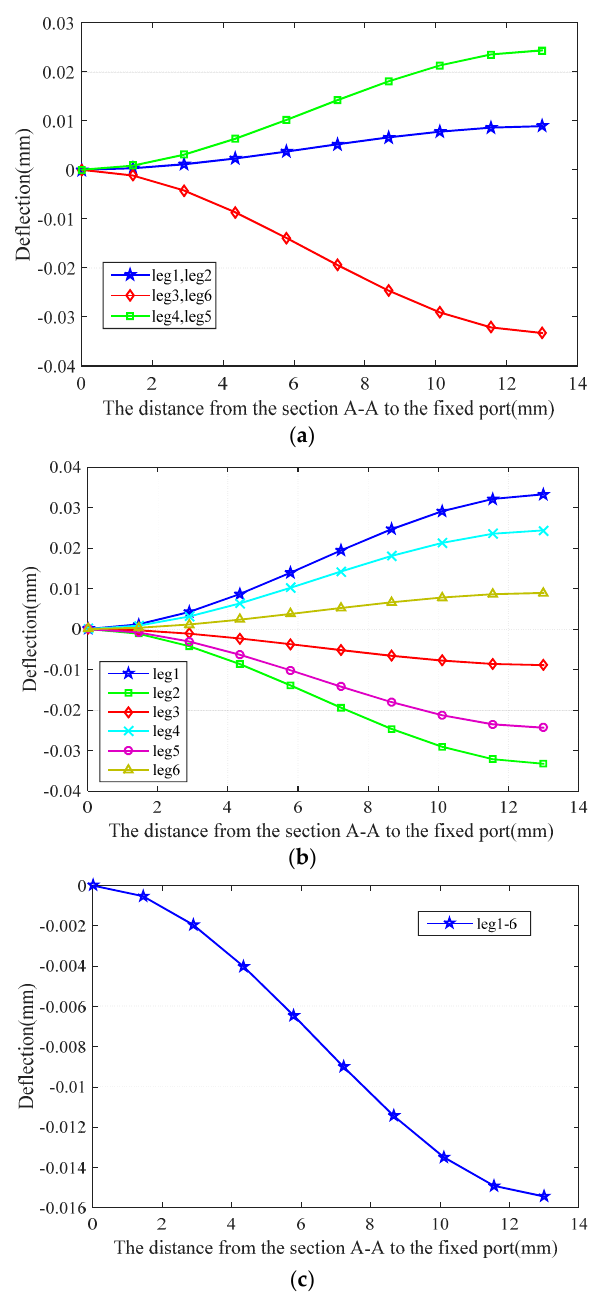
Figure 4. Deformation of the six beams: ( a ) deformation under a load g x on the moving platform; ( b ) deformation under a load g y on the moving platform; and ( c ) deformation under a load g z on the moving platform.